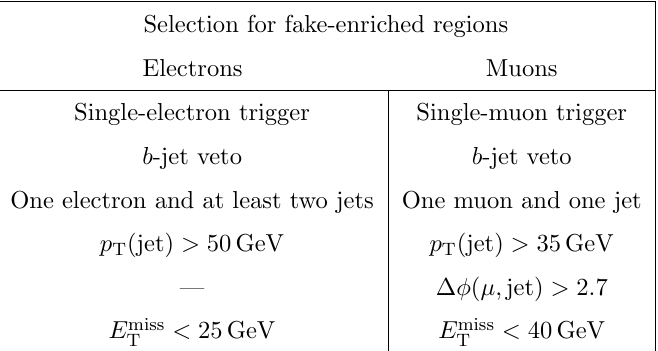
Table 3 . Selection criteria de(cid:12)ning the dedicated fake-enriched regions, used to measure the electron and muon fake-factors as described in the